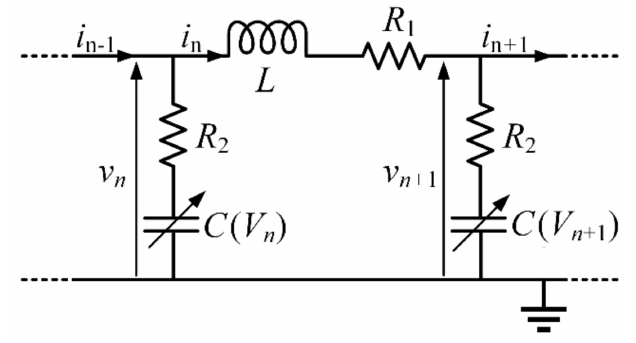
Figure 1. The n th unit cells of the lossy NLTL model.